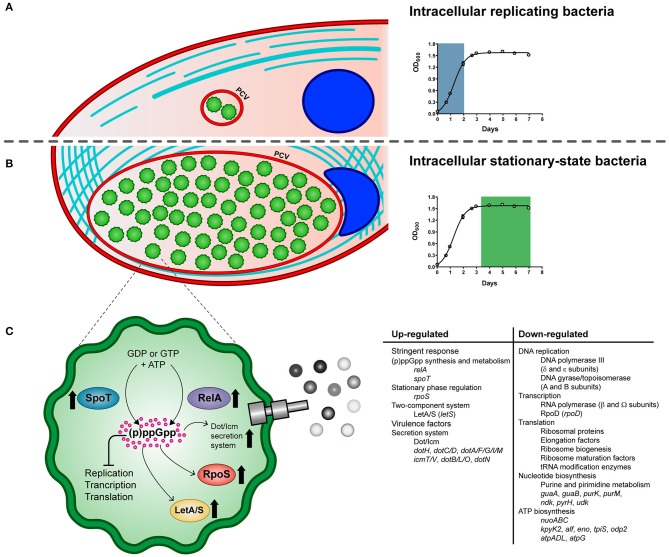
Schematic model of the life cycle of P. salmonis. The pathogen alternates between an intracellular replicative phase (A) and a stationary phase (B). Entry into stationary phase activates the stringent response of P. salmonis
(C). It is suggested that amino acid and fatty acid starvation triggers RelA and SpoT to produce the (p)ppGpp. Its accumulation induces the activation of the stress sigma factor RpoS and the LetA/LetS two component system along with a global shutdown of translation, transcription, and replication processes. In addition, several components of the Dot/Icm Type IVB secretion system are induced. PCV: P. salmonis-containing vacuole.